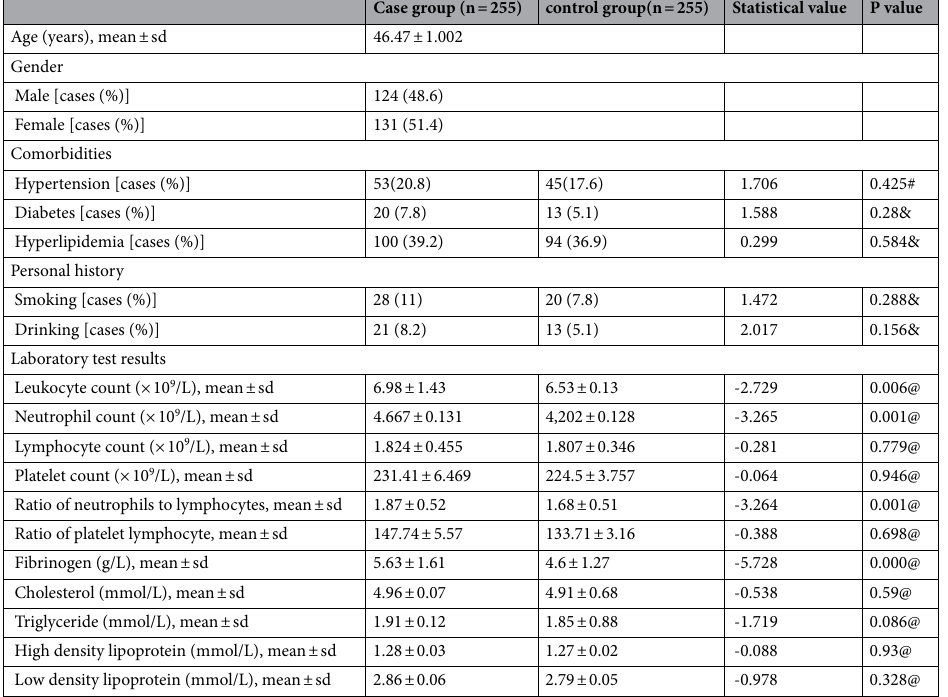
Table 2. Clinical characteristics, comorbidities and laboratory examination results of patients in case group and control group. # Fisher’s exact test, & The Chi-squared test, @ nonparametric Mann Whitney U